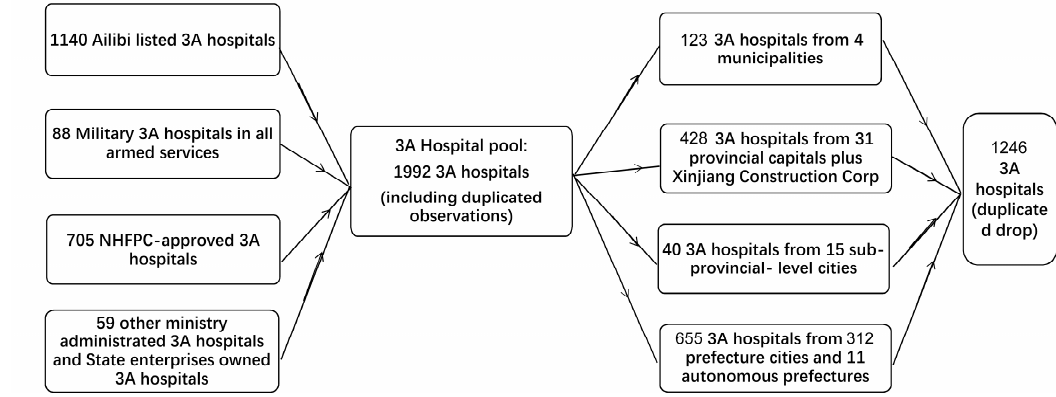
Figure 1. Data Collection and the Data Sorting Process. Source: Compiled by the authors.